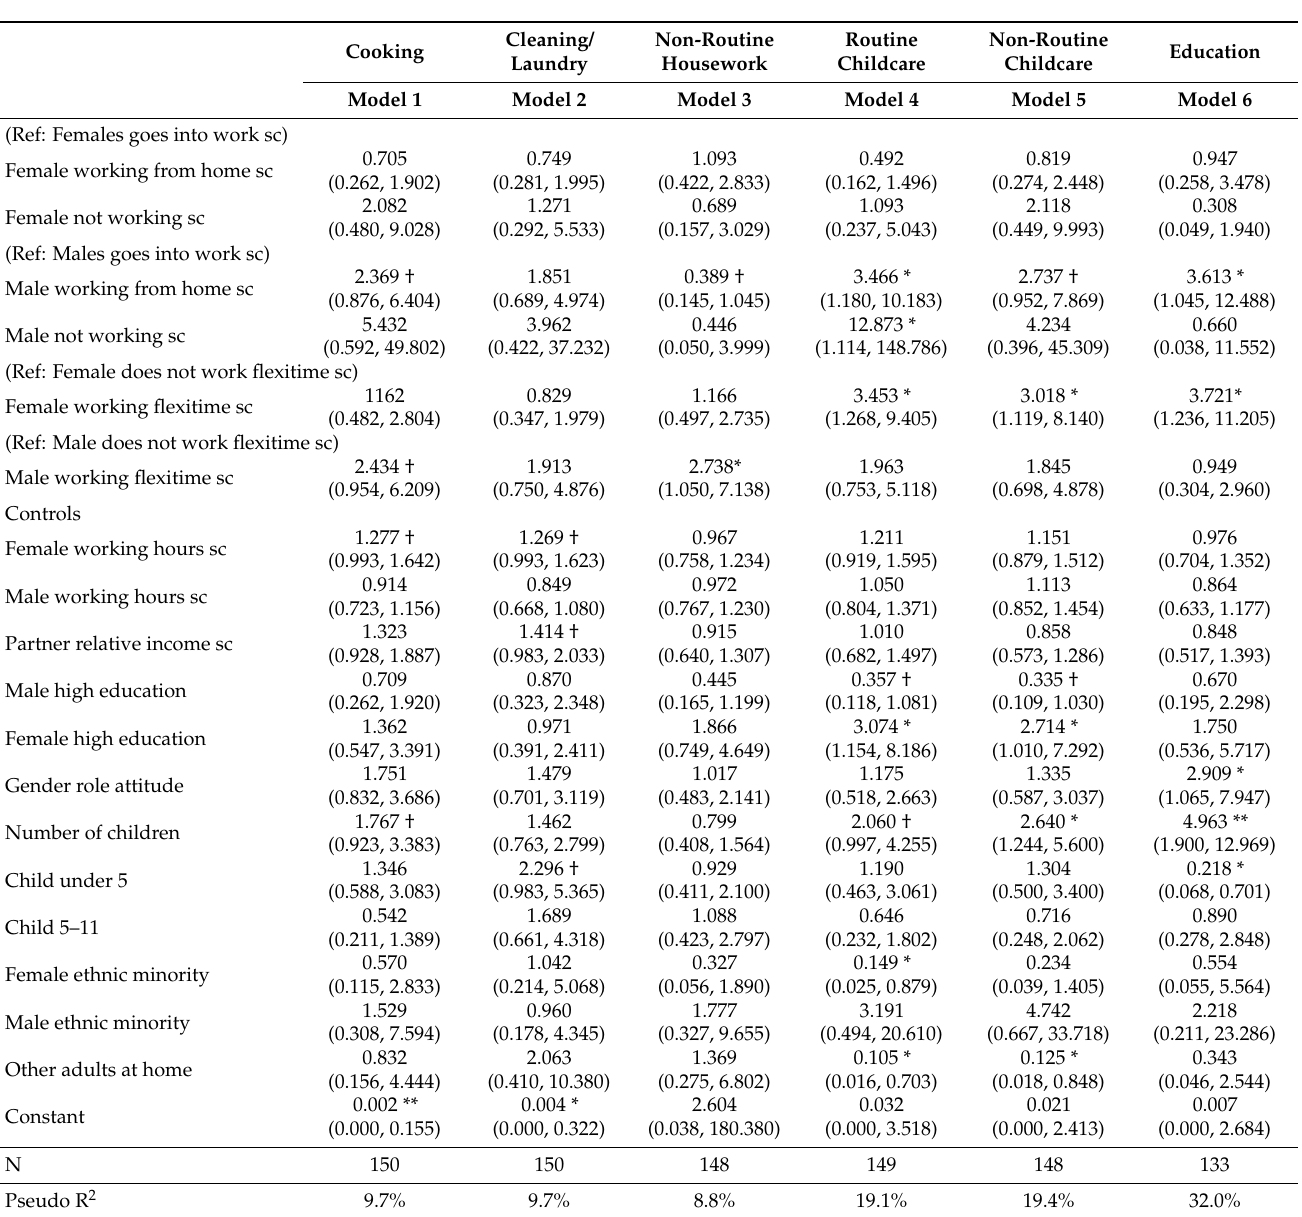
Table 2. Model explaining the changes in the amount of housework and childcare men carried out during the COVID-19 lockdown compared to before the lockdown for heterosexual dual earning couples with children under 18 (male respondents’ perception of their own time)—dichotomous (more or much more). Cleaning/ Cooking